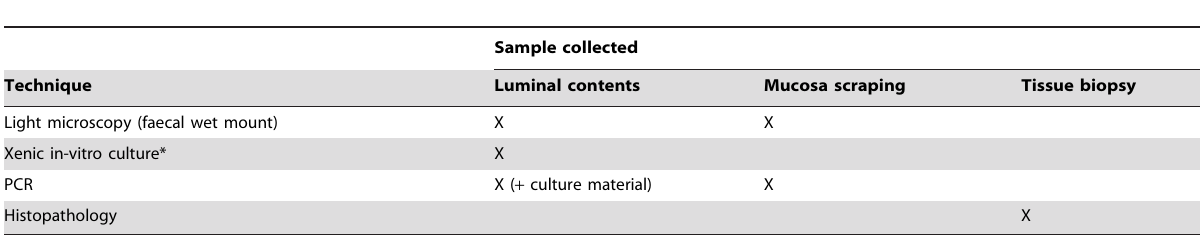
Table 1. Samples collected and tests carried out from each segment of porcine